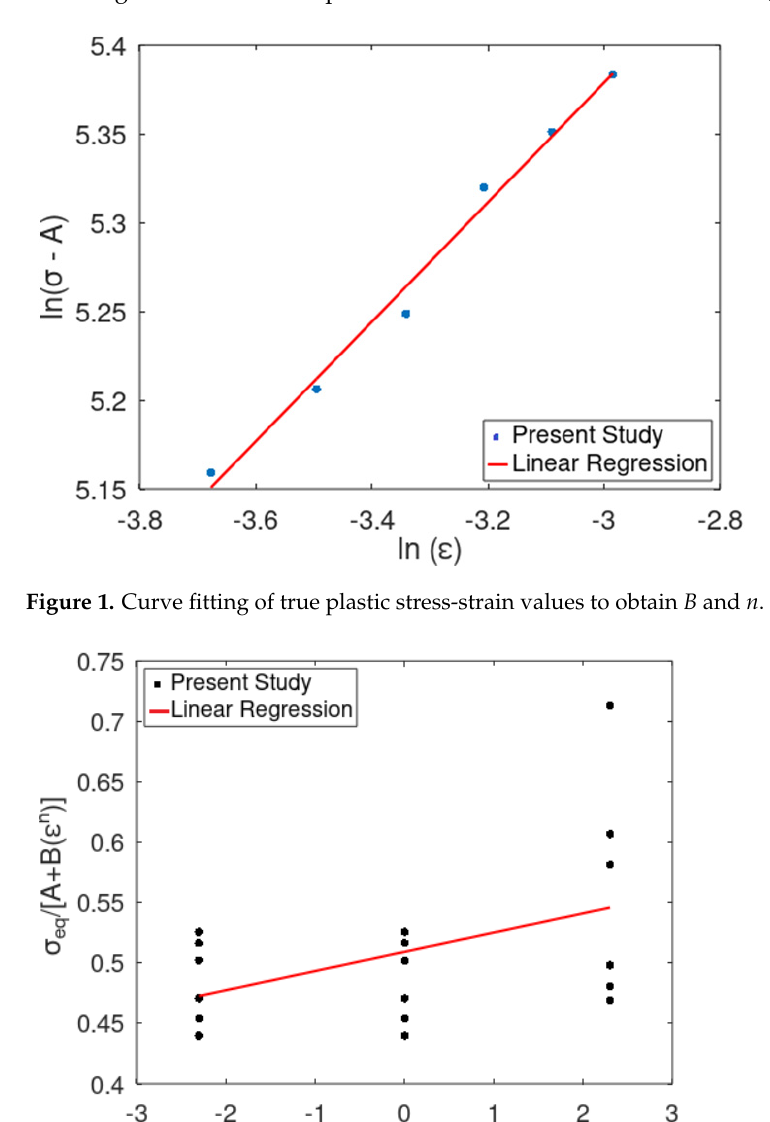
Figure 3. Schematic diagram of SHPB. Table 2. True stress-true strain values given as input to SHPB simulations in present study [41]. For Strain Rate- 2220/s